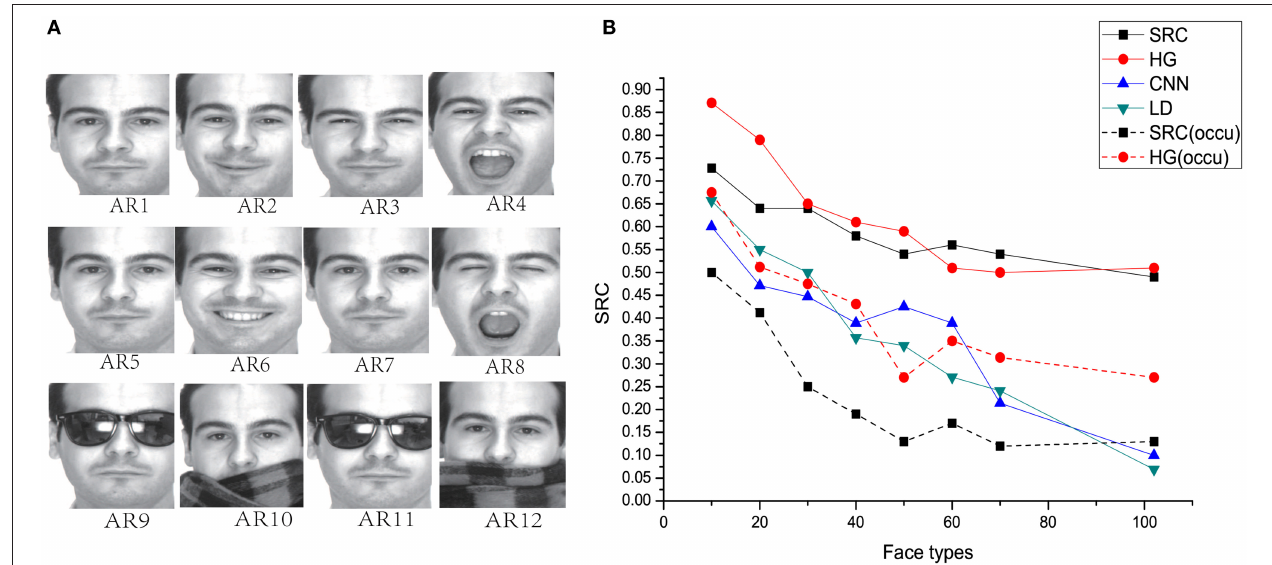
FIGURE 10 | (A) AR face database: AR1&AR5 neutral, AR2&AR6 smile, AR3&AR7 anger, AR4&AR8 scream, AR9&AR11 sunglasses AR10&AR12 scarf. (B) Comparison of HG (our method) with the other models on the performance of AR face database with different number of individual